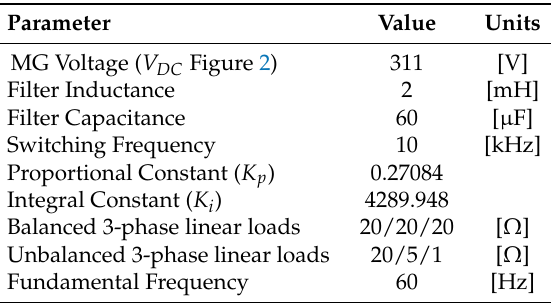
Table 2. Parameters of the MG